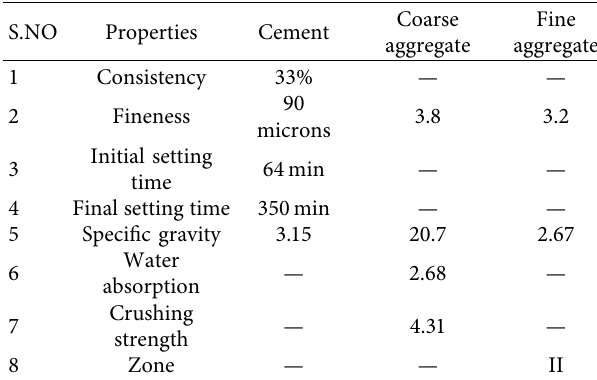
Table 1: Test results for materials used in concrete. Table 2: Properties of glass fiber.